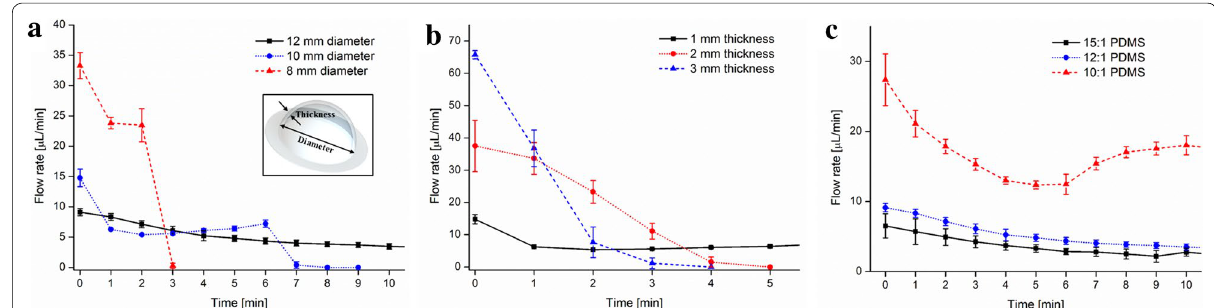
Fig. 4 Effect of the PDMS suction cup geometry and fabrication conditions on the pumping performance. a Effect of diameter (thickness: 1 mm; 12:1 PDMS), b thickness (diameter: 10 mm; 12:1 PDMS), and c mixing ratio (base/curing agent) of PDMS (diameter: 12 mm; thickness: 1 mm). All measurements are performed in triplicate